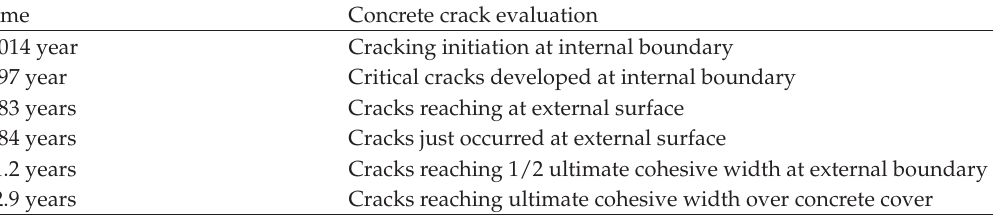
Figure 13: Radial stress (cid:5) σ r (cid:6) varying over concrete cover at various times. Table 2: Selected times during cover concrete cracking